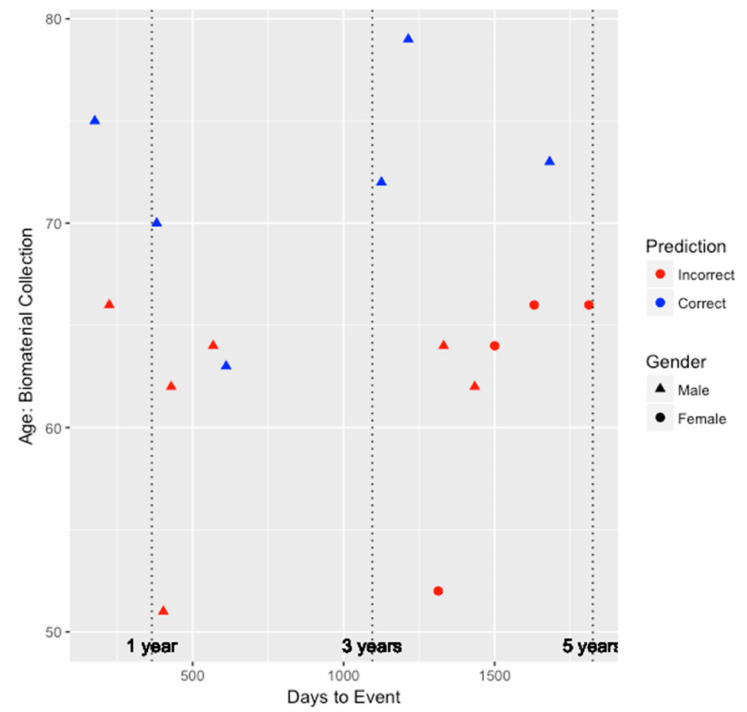
Figure 3. The performance of the ASCVD risk estimator when identifying those at high risk of symptomatic CHD within five years by age, gender, and days to